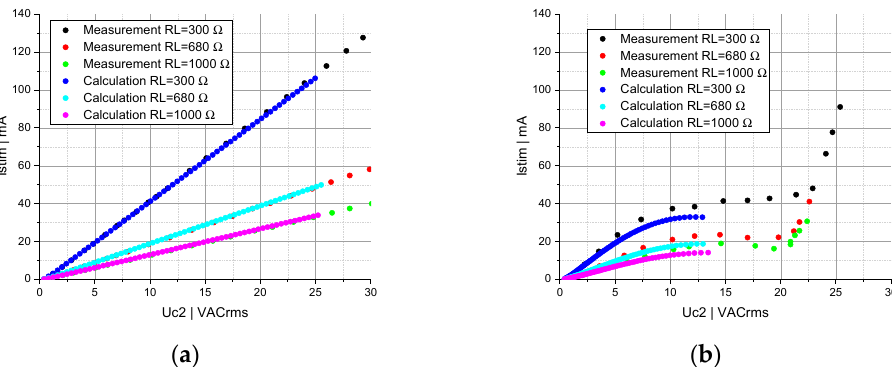
Figure 6. Stimulation current Istim as a function of the induced voltage Uc2 for a circuit topology consisting of: ( a ) linear capacitor; ( b ) nonlinear capacitor. The measurements (black, red, green) and calculations (blue, cyan, magenta) were performed for R L = 300 Ω , 680 Ω and 1000 Ω , respectively.